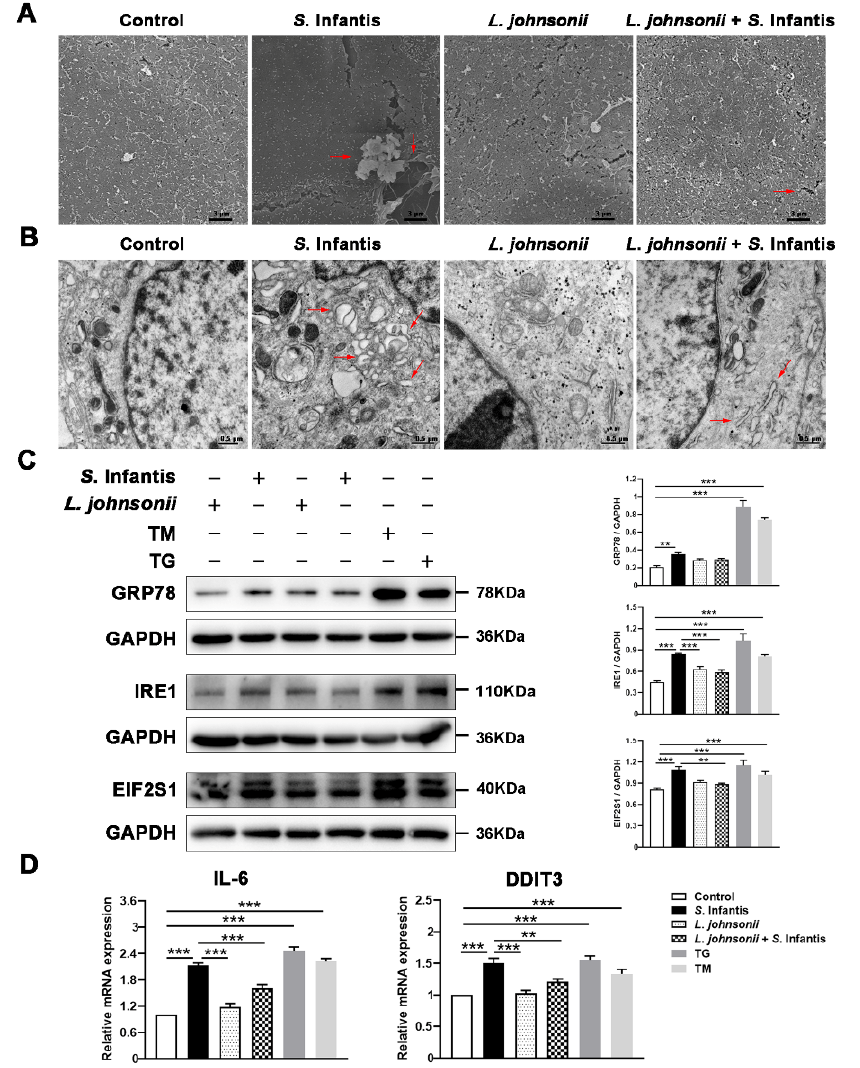
Figure 5. L. johnsonii L531 alleviates S. Infantis-induced ER stress and cellular ultrastructural damage in Caco2 cells. ( A ) Effect of L. johnsonii L531 on the structure of the ER in Caco2 cells after S. Infantis infection as observed using SEM. Red arrows indicate the damage caused by S . Infantis. ( B ) Effect of L. johnsonii L531 on the structure of apical surface in Caco2 cells after S. Infantis infection as observed using TEM. Red arrows indicate the damage caused by S . Infantis. ( C ) Western blotting analysis for GRP78, IRE1, and EIF2S1 in Caco2 cells. The right panels show the protein quantitation using Image J software. ( D ) Expression of Il 6 and DDIT3 mRNA in Caco2 cells. Data are represented as mean ± SEM, n = 3, ** p < 0.01, *** p <